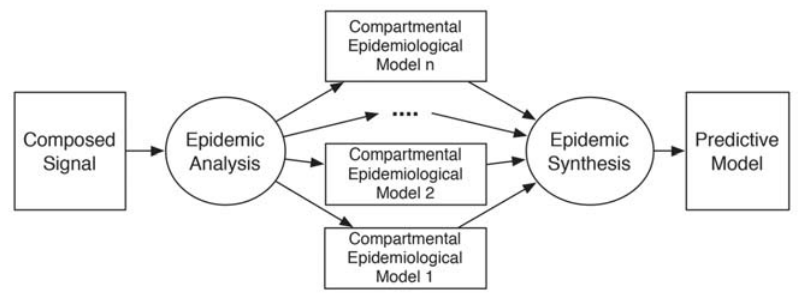
Figure 1: The proposed synthedemic modelling and prediction